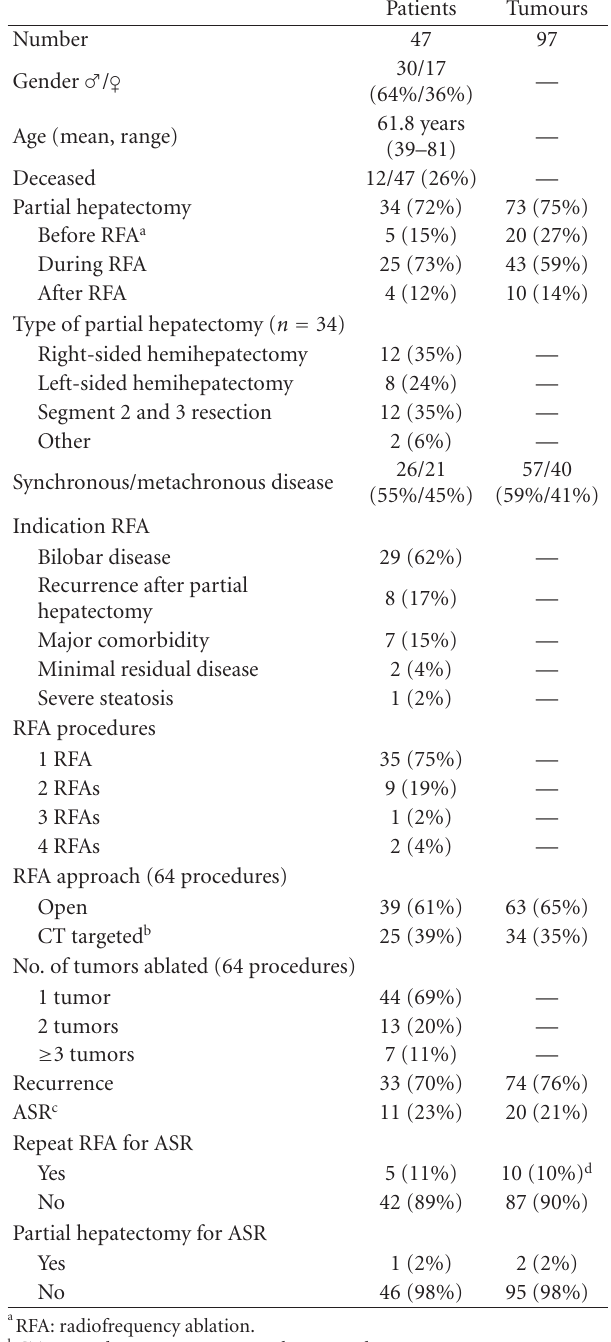
Table 1: Patient and tumour